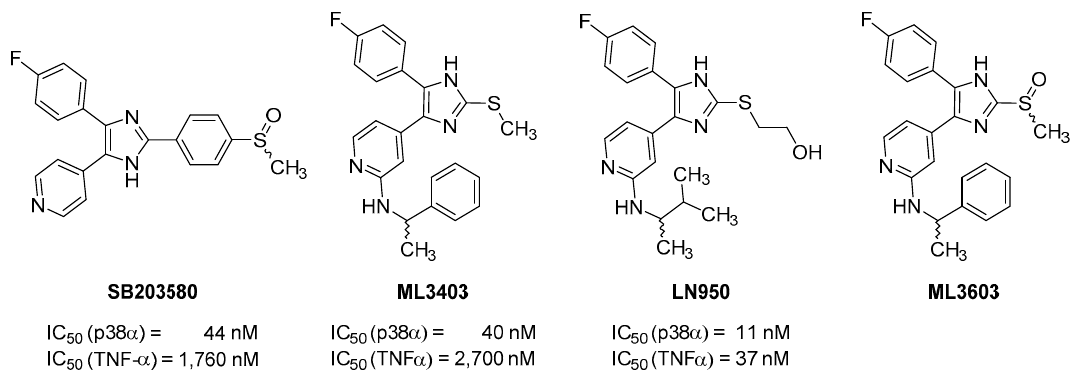
Figure 1. Pyridinylimidazoles as p38 α MAP kinase inhibitors.